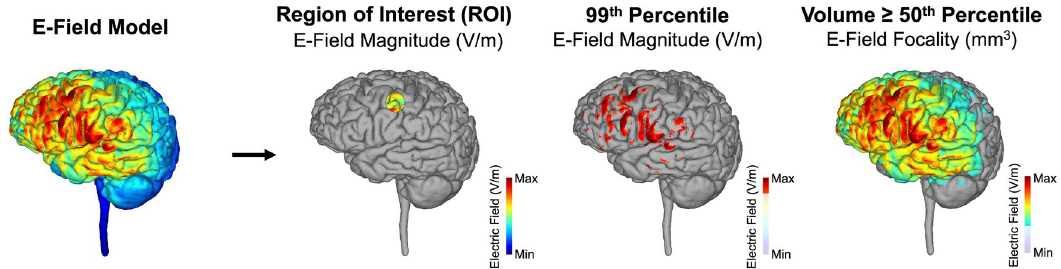
Round 1: Effects of electrode positioning in conventional vs. novel electrode montages. In Round 1, we compared conventional electrode montages and two novel placements surrounding the cortical target. In our ROI analysis, we found that varying electrode positioning produced significantly different elec- tric fields at the motor ROI, F(1.8, 361.4) = 169.0, p < 0.0001. Post-hoc Tukey corrected analyses indicated that each comparison statistically differed at the p < 0.0001 significance level except for the conventional bilateral M1 and M1-SO montages (Fig. 4a). In particular, APPS-tDCS electrodes that surround the cortical motor target by placing electrodes in the anterior and posterior directions produced the highest mean E-field of 0.363 V/m (SD = 0.081 V/m), compared to LRPS-tDCS (mean = 0.326 V/m, SD = 0.067 V/m), HD-tDCS (mean = 0.306 V/m, SD = 0.126 V/m), bilateral M1 (mean = 0.271 V/m, SD = 0.054 V/m), and M1-SO (mean = 0.273 V/m, SD = 0.053 V/m) (Fig. 4a; Table 2). The 99th percentile E-field magnitude was also significantly impacted by electrode positioning, F(1.9, 371.9) = 843.6, p < 0.0001 (Fig. 5a and Table 2). Post-hoc Tukey corrected tests revealed that the conven- tional bilateral M1 and M1-SO montages produced the two highest 99th percentile E-fields of 0.363 V/m (SD = 0.063 V/m) and 0.392 V/m (SD = 0.061 V/m) respectively. These values were significantly higher than HD-tDCS (mean = 0.209 V/m, SD = 0.086 V/m), LRPS-tDCS (mean = 0.297 V/m, SD = 0.056 V/m), and APPS- tDCS (mean = 0.316 V/m, SD = 0.069 V/m). Each post-hoc comparison was significant at the p < 0.0001 signifi- cance level. Regarding focality, electrode placement significantly altered the spread of electric fields, F(2.0, 402.8) = 2975, p < 0.0001 (Fig. 6a and Table 2). Tukey corrected post-hoc comparisons revealed that the volume stimulated from each electrode montage significantly differed at the p < 0.0001 significance level. HD-tDCS delivered the most